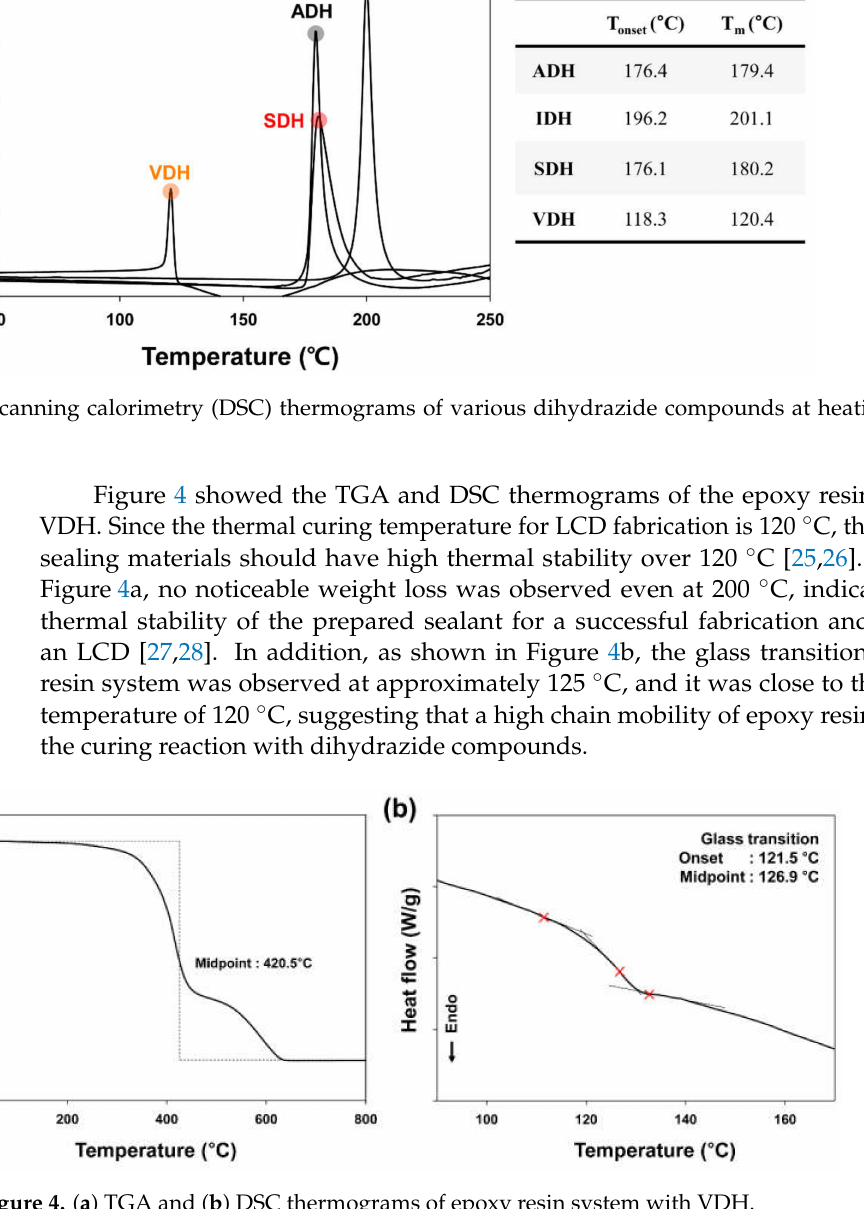
Figure 4. ( a ) TGA and ( b ) DSC thermograms of epoxy resin system with